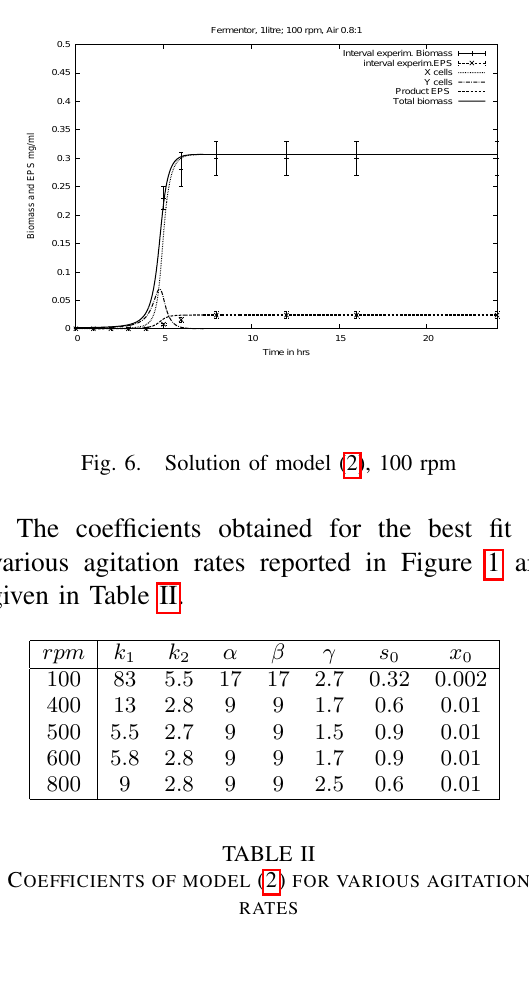
600 rpm. Note that these are the agitation rates